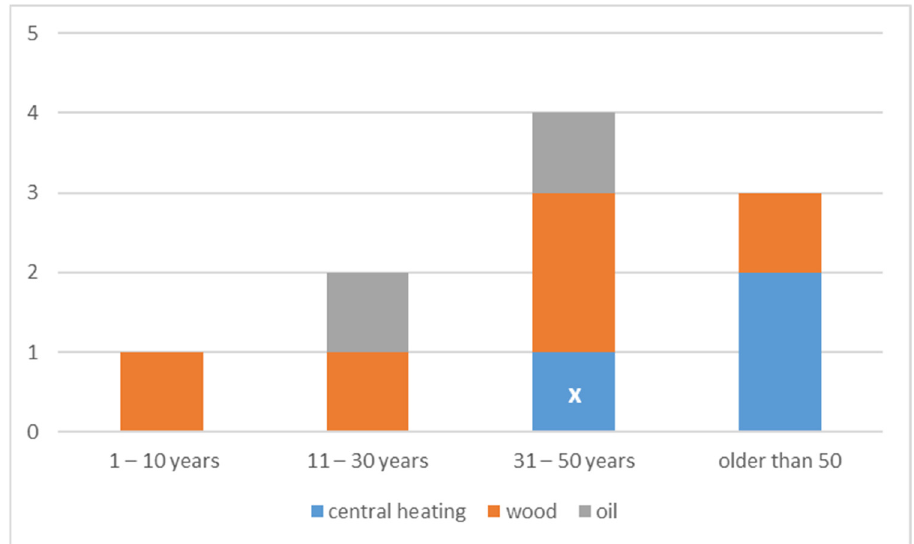
Figure 1. School building age and type of heating (x: mechanical ventilation).